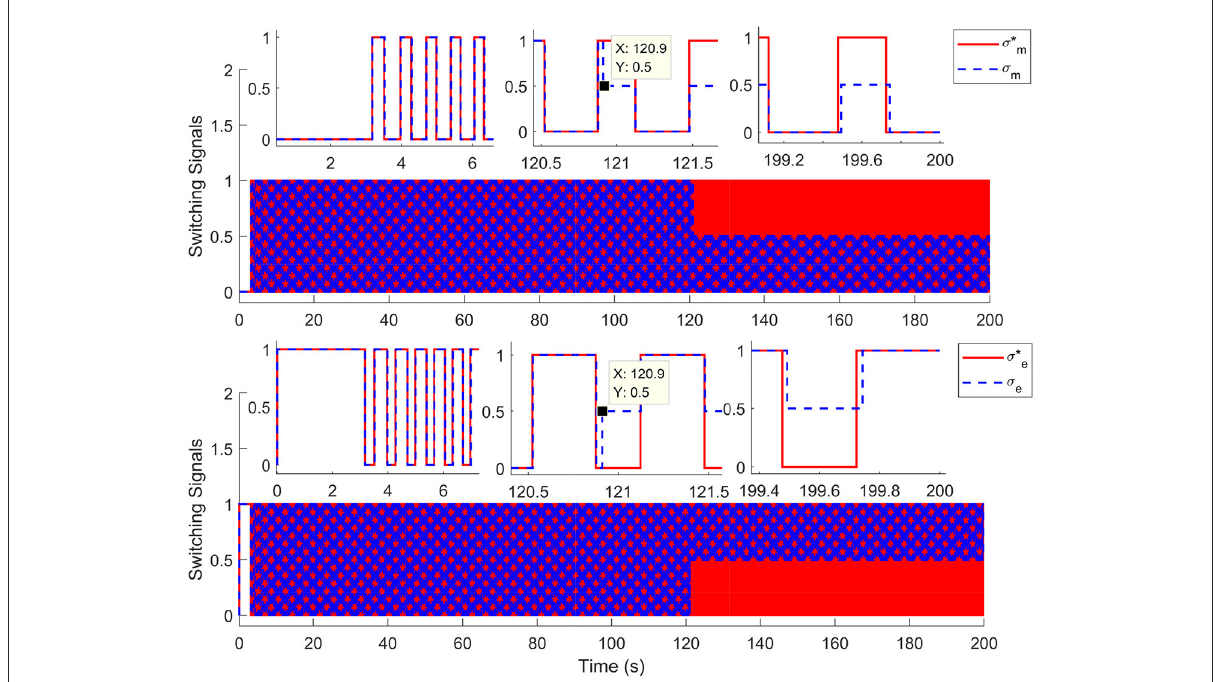
FIGURE4 The switching signals for nominal system and time delays system. The red solid lines ( σ ∗ m , σ ∗ e ) and the blue dotted lines ( σ m , σ e ) represent the switching signals of the nominal and time delay systems, respectively.